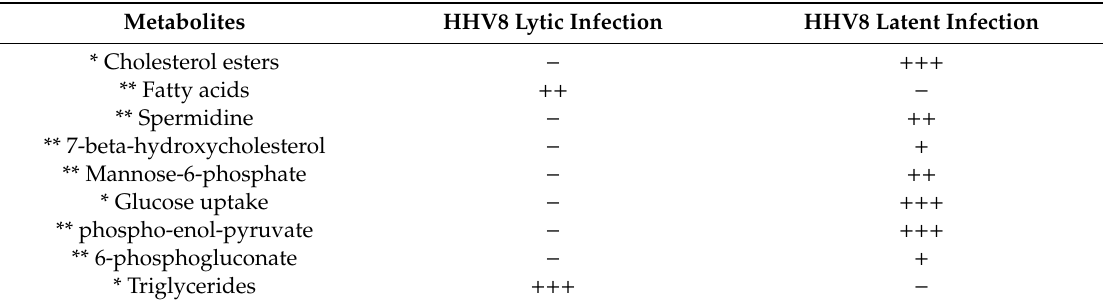
Table 1. Modification of some biochemical parameters in HHV8 infected endothelial